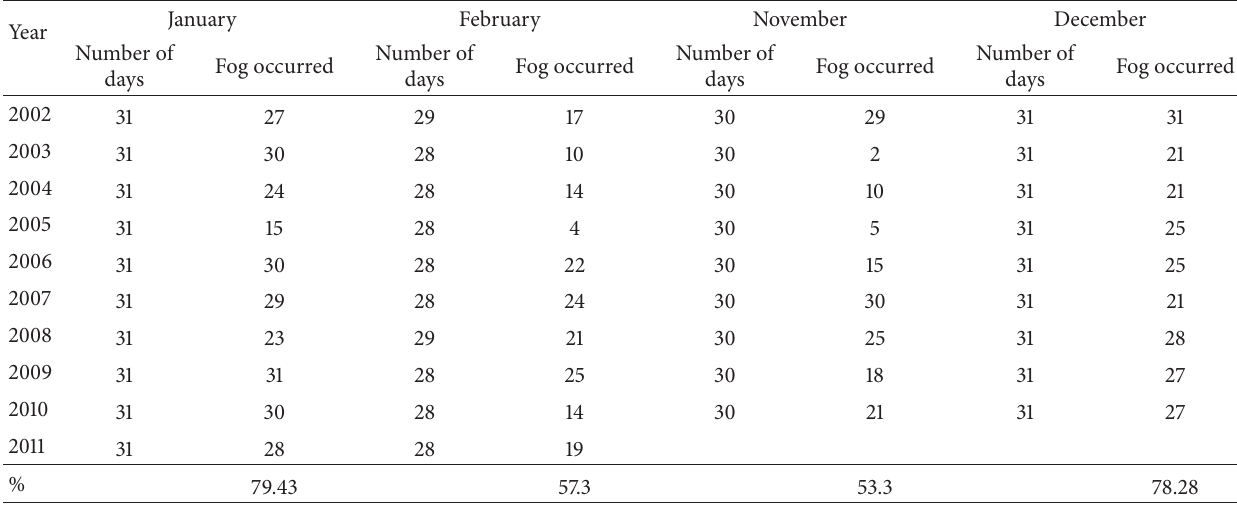
Table 1: Number of occurrences of fog days over Delhi in winter months (January, February, November, and December) of 2002 to